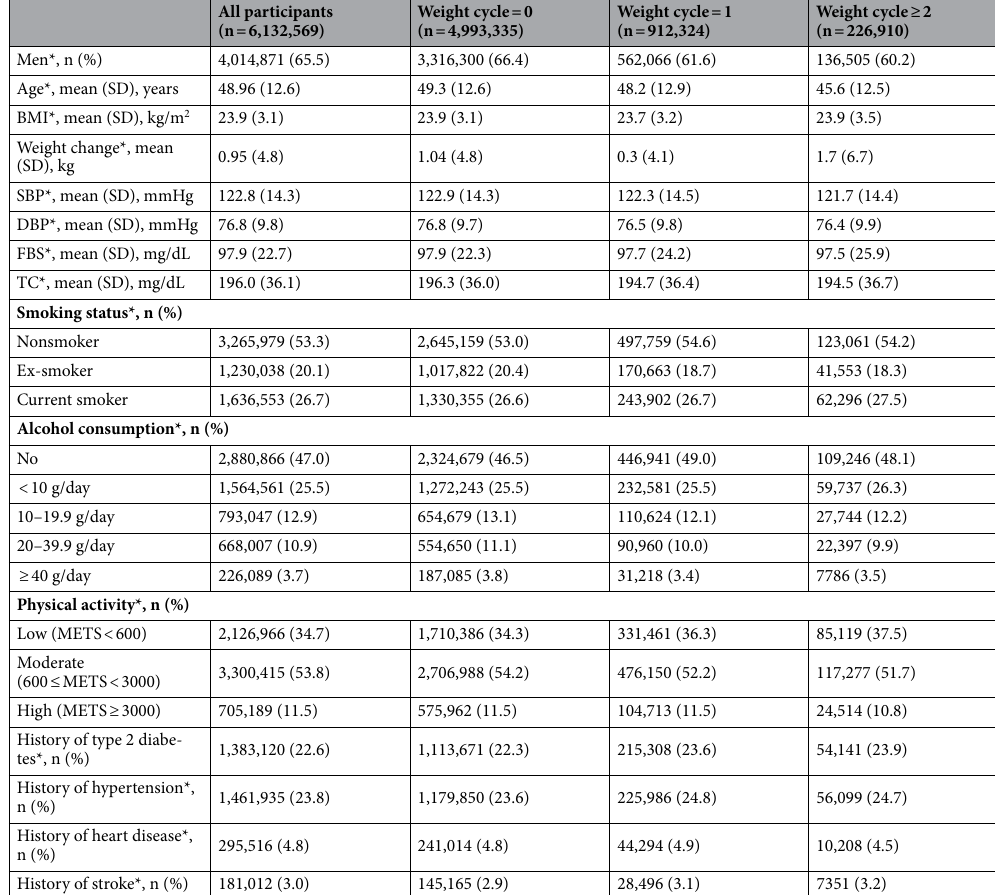
Table 1. Baseline characteristics of the participants according to the number of BW cycles defined with 7% BW. SBP systolic blood pressure, DBP diastolic blood pressure, FBS fasting blood sugar, TC serum total cholesterol, BMI body mass index. *Indicate p-value < 0.0001 across three groups (weight cycle = 0, 1, or ≥ 2) based on ANOVA and Chi-squared